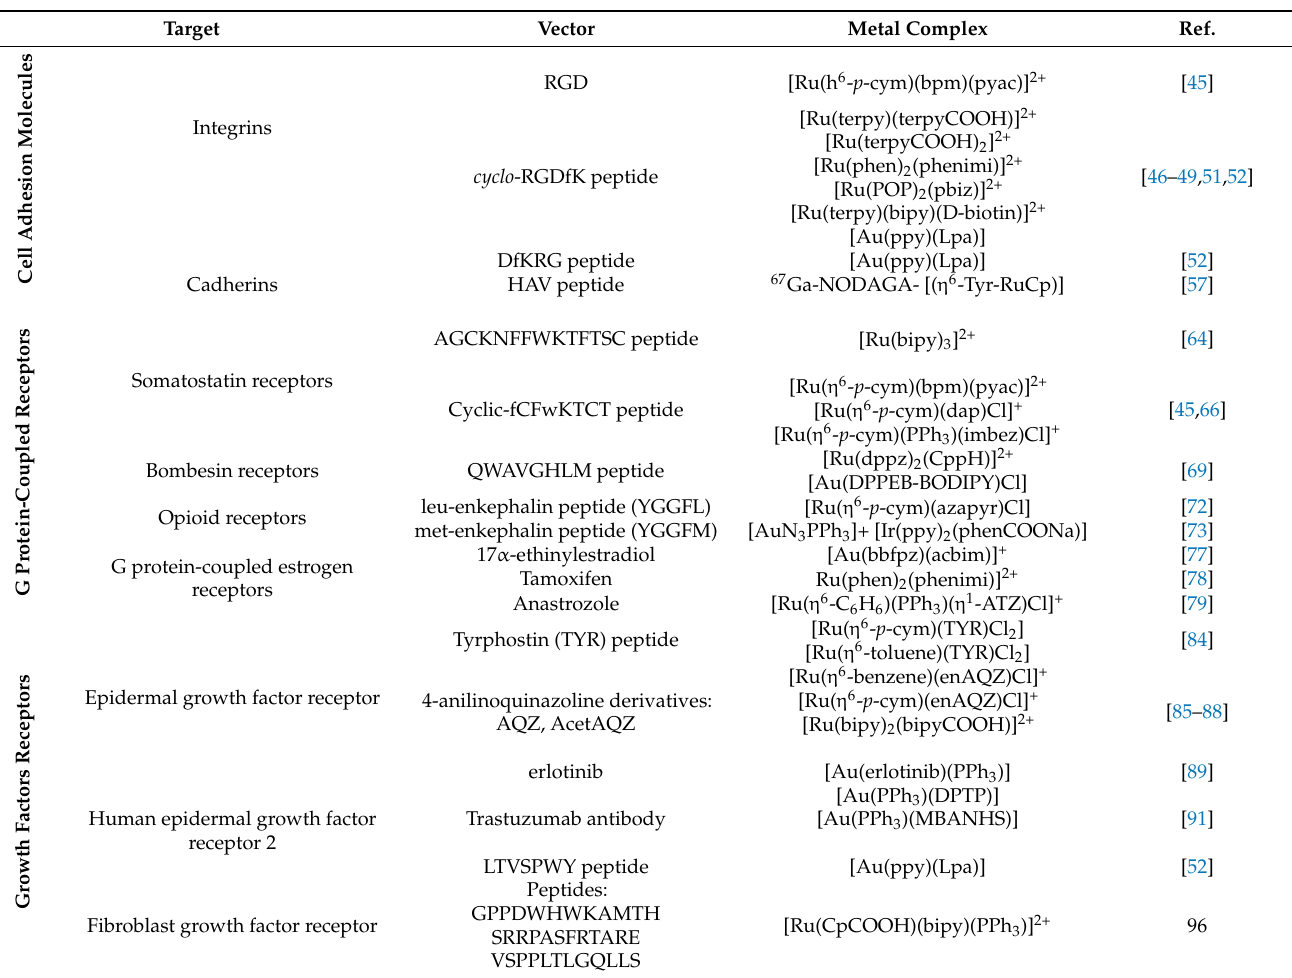
Table 1 summarizes the ruthenium and gold complexes that were conjugated to dif- ferent vectors exploited to target emerging molecular receptors, namely cell adhesion molecules (integrins and cadherins), G-protein coupled receptors (somatostatin recep- tors, bombesin receptors, and opioid receptors) and growth factor receptors (epidermal growth factor receptor, human epidermal growth factor receptor 2, and fibroblast growth factor receptor). Table 1. Ru and Au metal complexes and their vectors developed for target membrane proteins: cell adhesion molecules, G-protein coupled receptors, and growth factor receptors. Target Vector Metal Complex